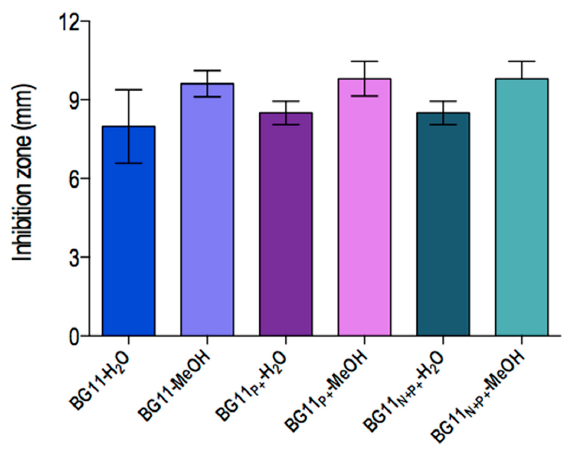
Figure 3. Antibacterial activity of Synechococcus sp. strain GFB01 extracts obtained from culture in di ff erent phosphate and nitrate concentrations against the Gram-negative